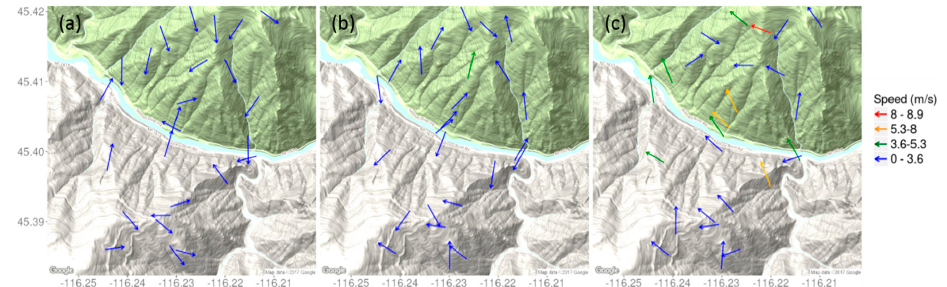
Figure 2. ( a ) Downslope winds at 0100 LT on 11 August 2011; ( b ) upslope winds at 1100 LT on 11 August 2011; and ( c ) gap winds at 1000 LT on 17 August 2011.